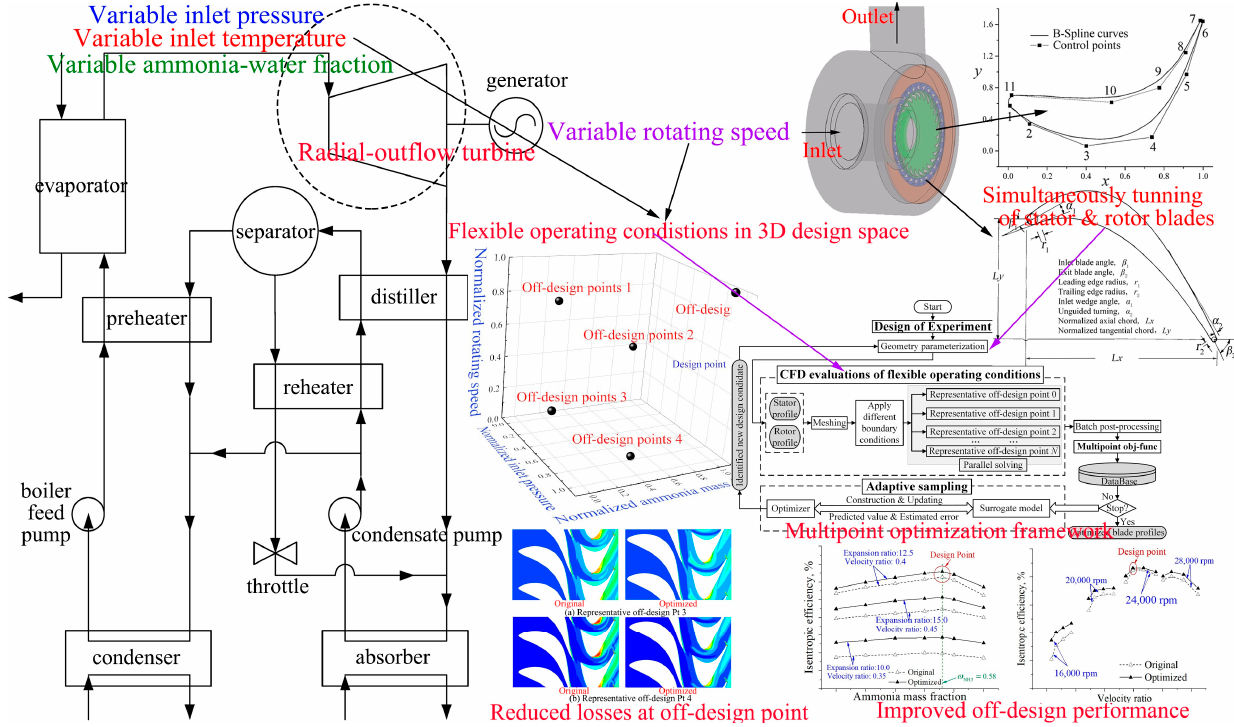
Figure 1. The abstract introduction of present work.